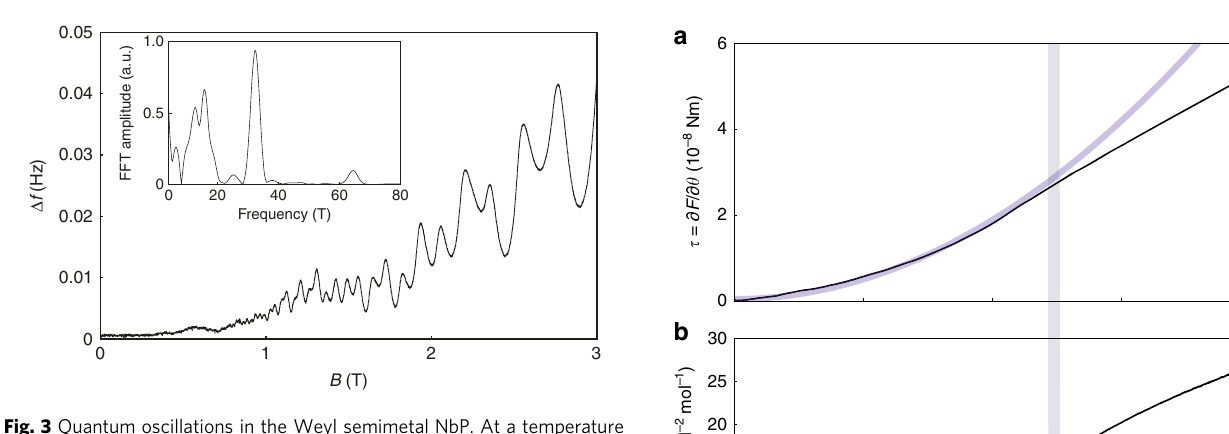
Here, Δ X indicates the jump of X across the phase boundary and d T * and d θ * are short segments along the phase boundary in the T − θ phase plane, such that d T */d θ * = ( ∂ T relation connecting the jump in the magnetotropic coef fi cient Δ k